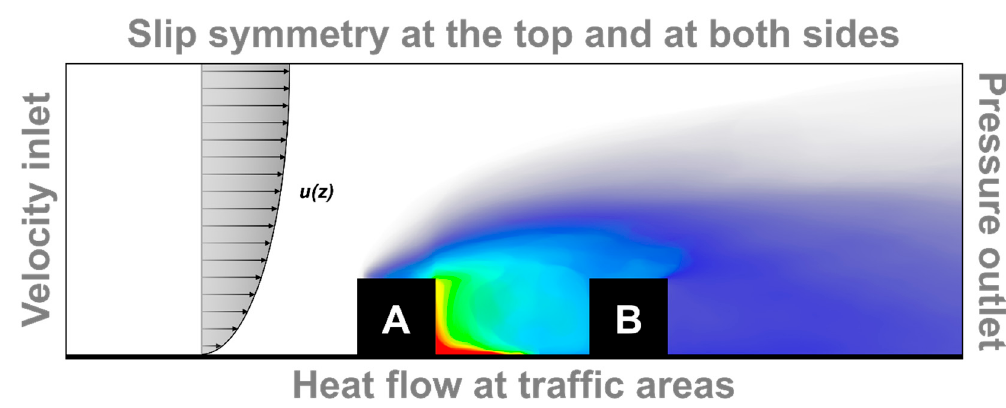
Figure 4. Boundary conditions in the virtual wind tunnel (geometric dimensions are not proportionate).